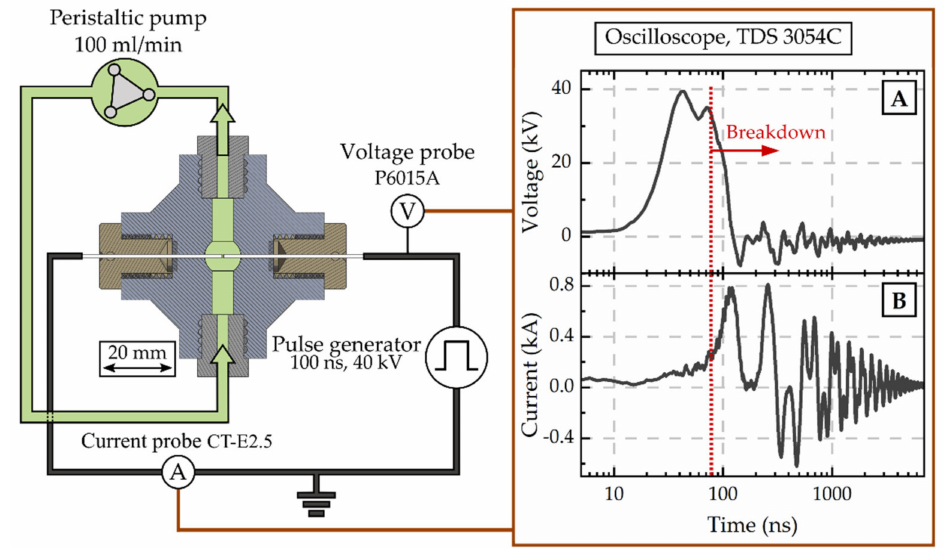
Figure 1. Schematic of the setup for the disintegration by spark discharges. The discharge chamber, algae pumping loop (green) as well as the electric circuit (black) with diagnostics, are displayed and typical voltage ( A ) and current ( B ) measurements are